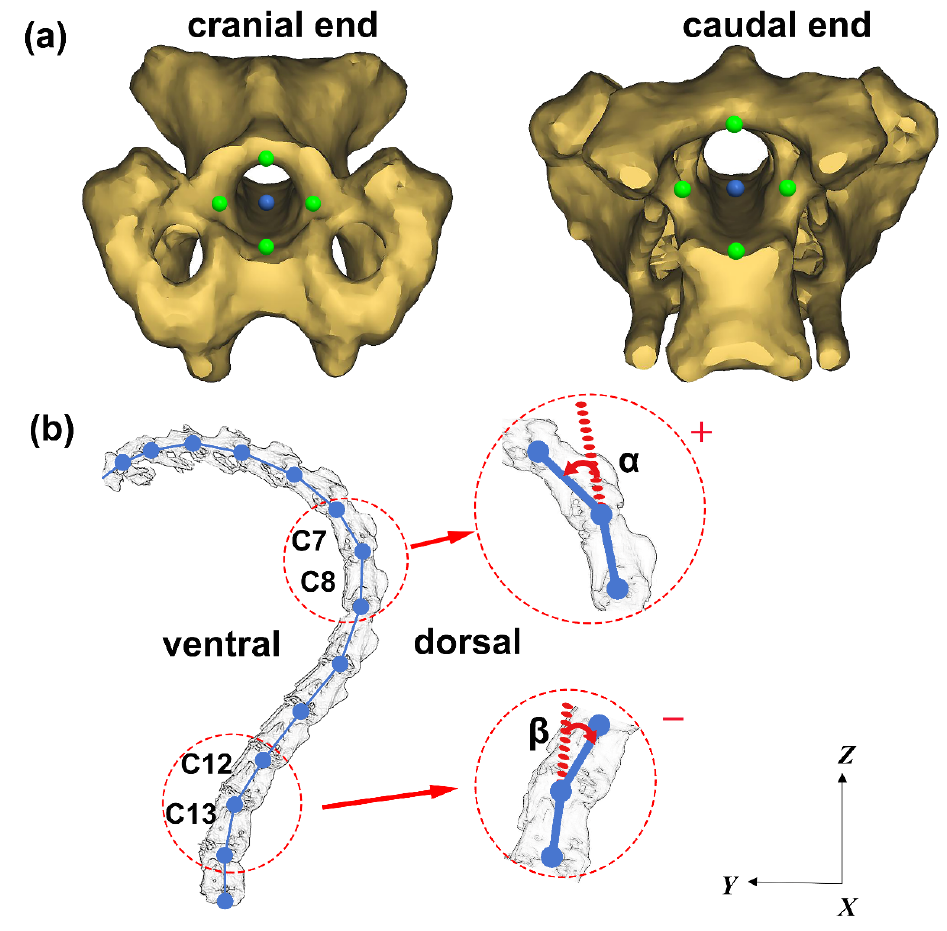
Figure 3. Schematic diagram for the ventroflexion/dorsiflexion motion measurement. ( a ) Represen- tative positions of the selected four points (in green) and the calculated central point (in blue) at the caudal end and the cranial end of an intervertebral foramen. ( b ) Schematic diagram showing the included angle between two adjacent vertebrae.